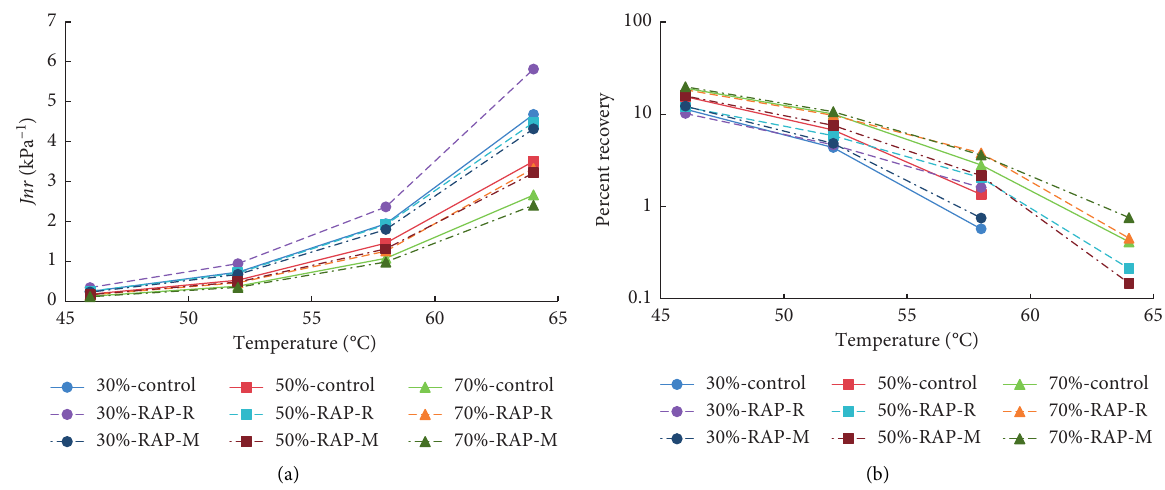
Figure 18: MSCR parameters of three types of recycled binders: (a) J